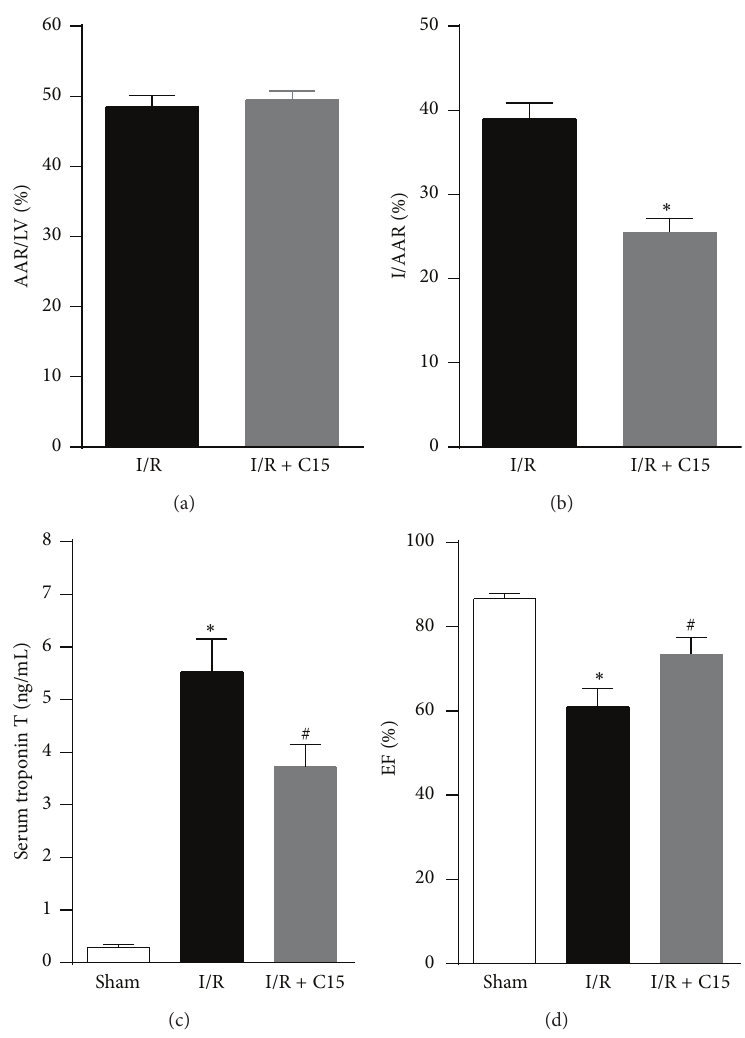
Figure 1: Chemerin15 (C15) decreased the myocardial infarct size and improved the hemodynamic performance following ischemia/reper- fusion(I/R).((a)and(b))Quantificationoftheareaatrisk/leftventriculararea(AAR/LV)andinfarctarea/AAR(I/AAR)24hafterreperfusion ( 𝑛 = 6 ). (c) Serum cardiac troponin T (cTnT) was measured in the sham, I/R, and I/R+C15 groups at 24h after I/R ( 𝑛 = 5 ). (d) The ejection fraction (%EF) was measured 48 h after reperfusion ( 𝑛 = 6 ). ∗ < 0.05 versus the I/R or sham groups; # < 0.05 versus the I/R